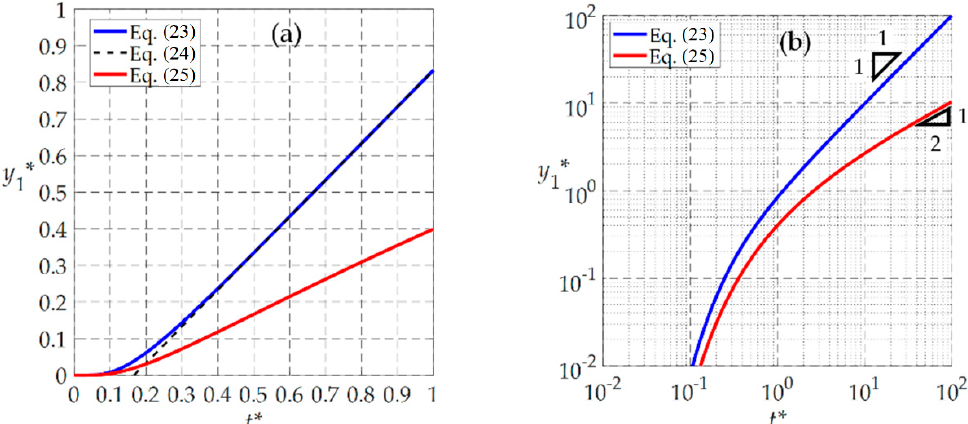
Figure 6. Shoreline evolution at the boundary with ( a ) normal plot and ( b ) log-log plot to show the difference of power to the dimensionless time